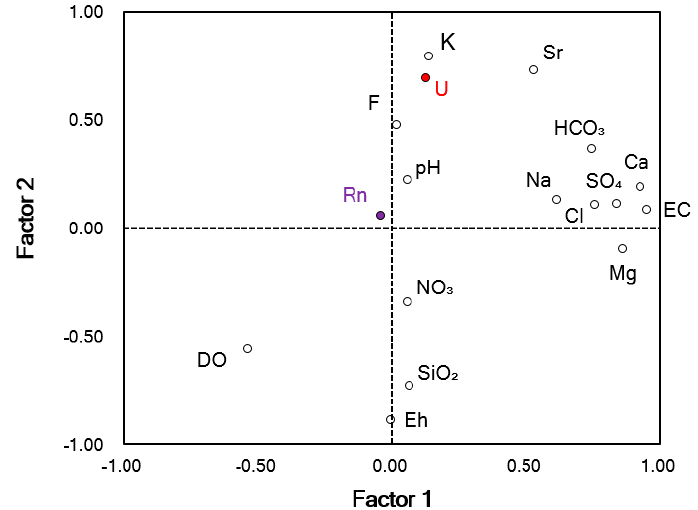
Figure 8. Plot of loadings for the strong two factors with Varimax normalized rotation showing some relationships among hydrogeological components in groundwater.